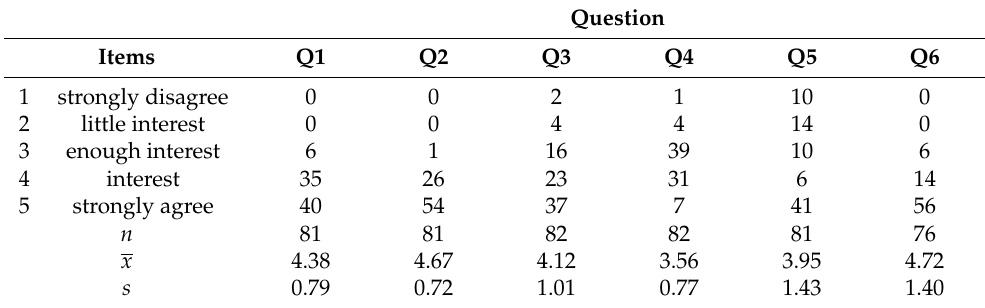
Table 2. The frequency distribution of items on the Likert scale according to Table 1.